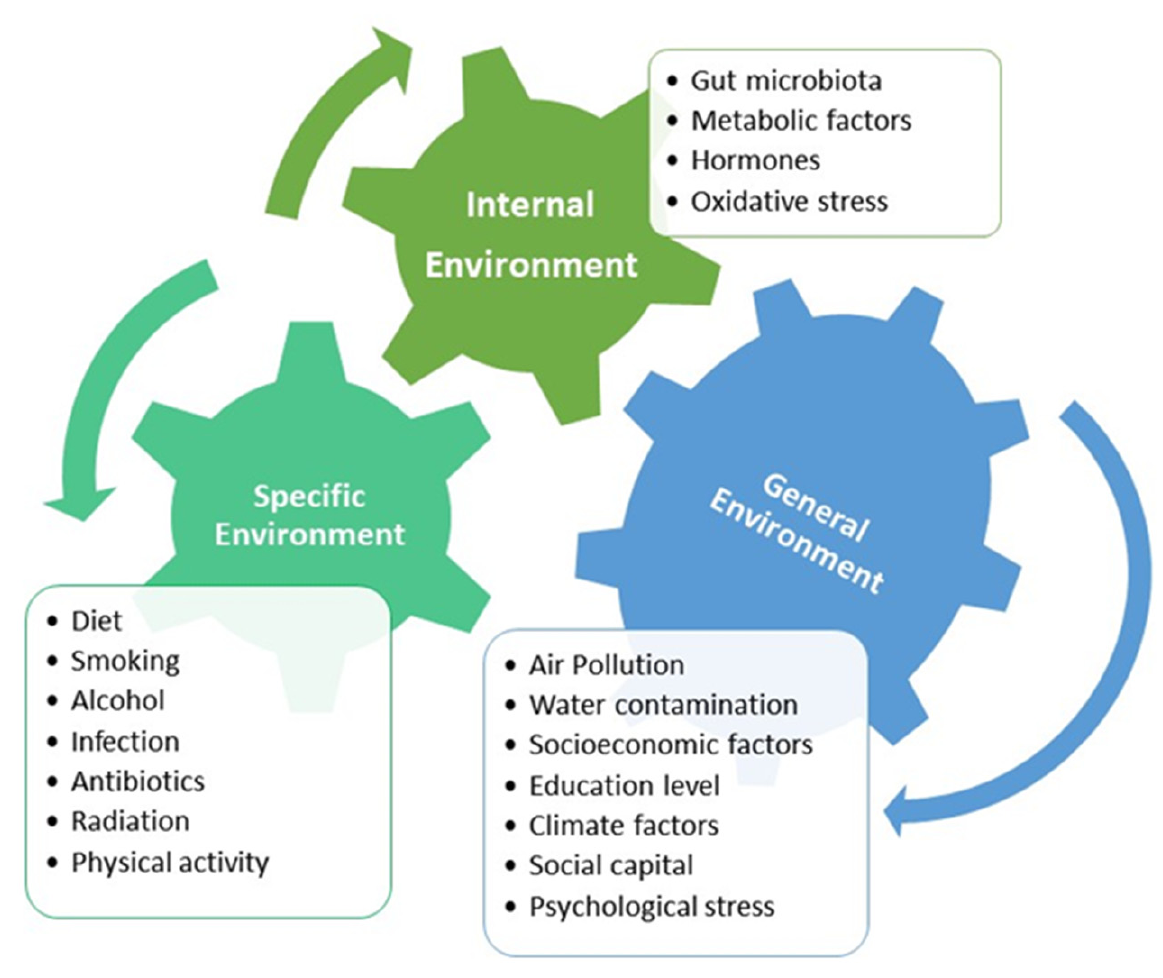
Figure 5. Three components of exposomes for colorectal Figure 5 . Three components of exposomes for colorectal cancer .